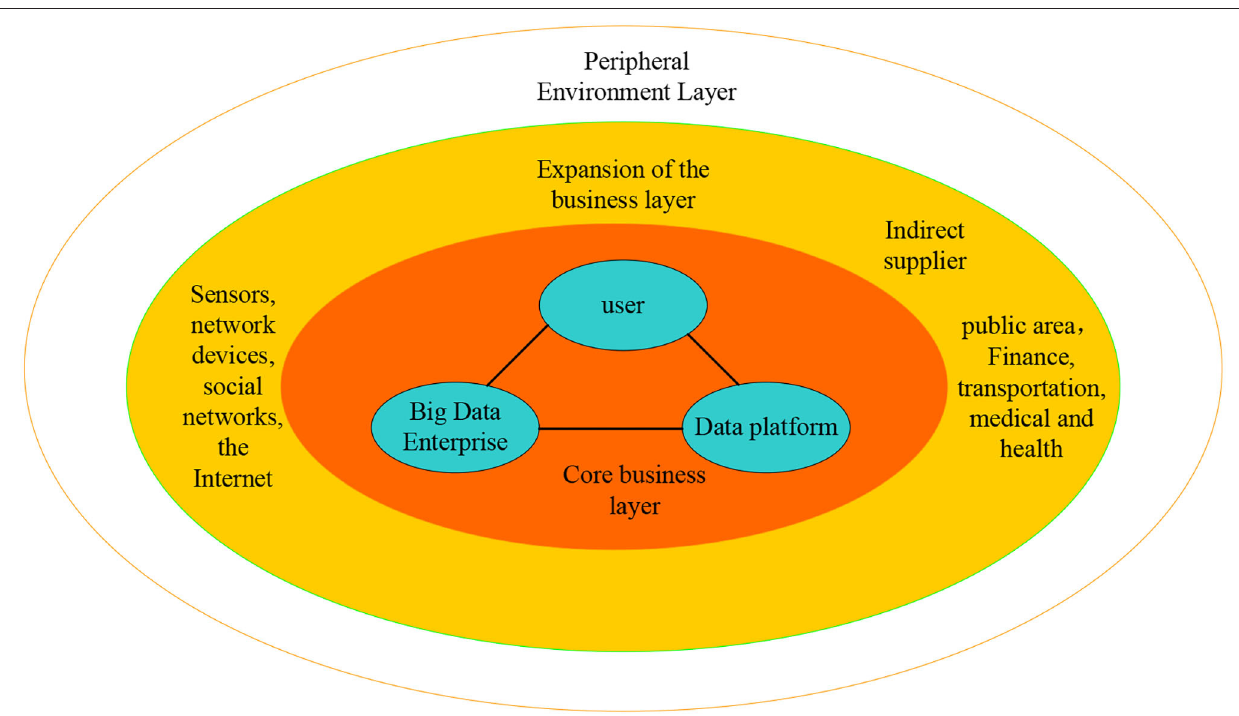
FIGURE 2 | Digital entrepreneurship ecosystem structure